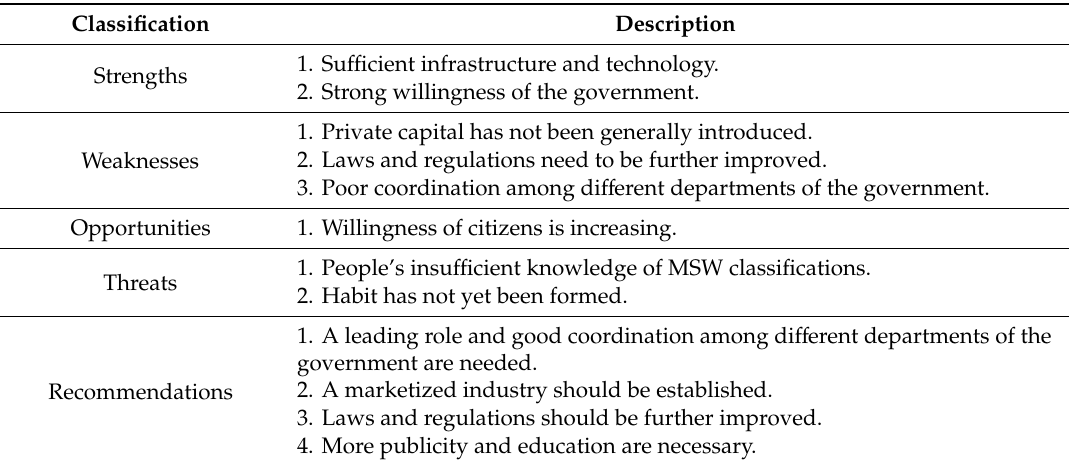
Table 1. Strengths, weaknesses, opportunities, and threats (SWOT) analysis on the present MSW classification policy in Shanghai.